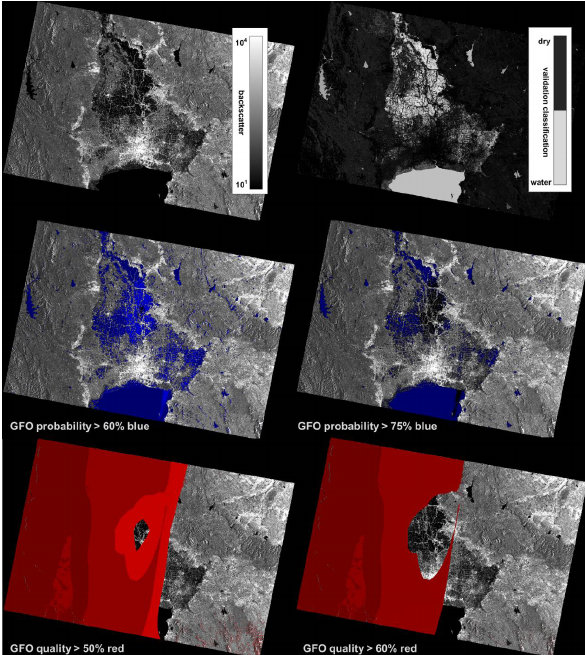
Figure 8. Validation of ASAR WSM image of 13 October 2011, Thailand. Top left: 3 Fig. 8. Validation of ASAR WSM image of 13 October 2011, Thai- backscatter values. Top right: flood classification with the validation algorithm. Middle left: 4 land. Top left panel: backscatter values. Top right panel: flood clas- GFO probabilities thresholded at 60%. Middle right: GFO probabilities thresholded at 75%. 5 sification with the validation algorithm. Middle left panel: GFO Bottom left: GFO qualities thresholded at 50%. Bottom right: GFO qualities thresholded at 6 probabilities thresholded at 60%. Middle right panel: GFO prob- 60%. 7 abilities thresholded at 75%. Bottom left panel: GFO qualities thresholded at 50%. Bottom right panel: GFO qualities thresholded at